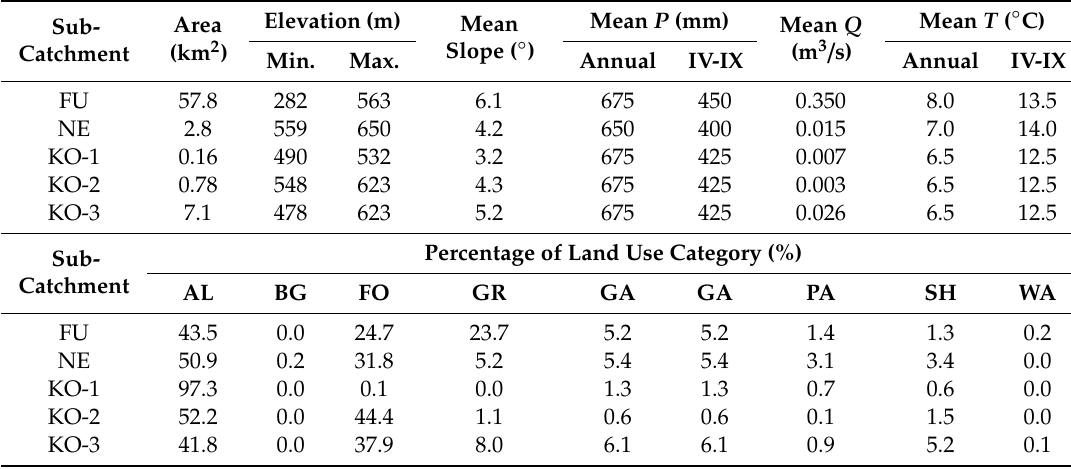
Figure 1. Overview map of the experimental catchments. Table 1. Basic characteristics of the experimental catchments and percentage of land use categories (AL—arable land; BG—bare ground; FO—forest; GR—grassland and meadows; GA—gardens and orchards; PA—paved and built-up areas; SH—shrubbery; WA—water